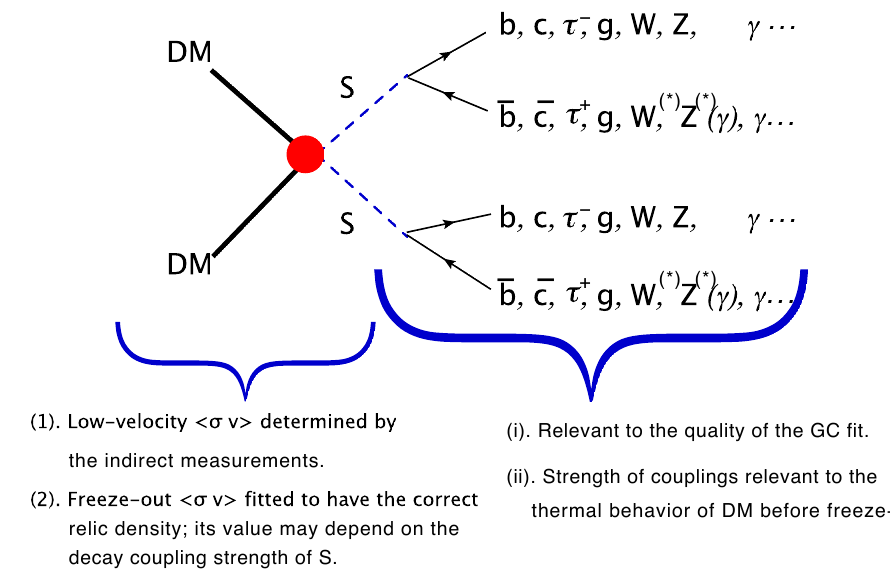
Figure 1 . Gamma-ray spectrum generated from one-step cascade annihilations of dark matter via the Higgs portal, where the hidden Higgs mediator is denoted as \ S